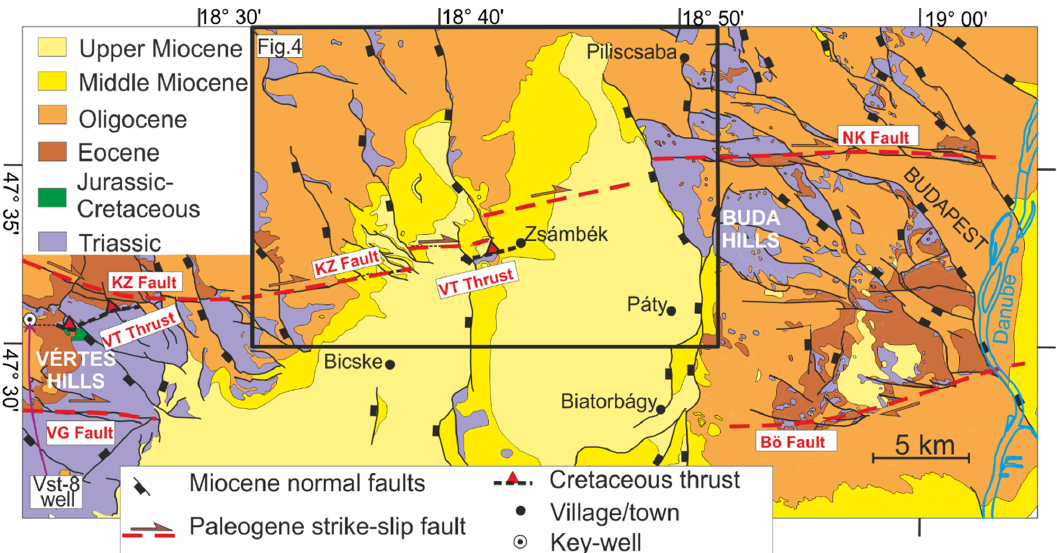
Figure 2. Pre-Quaternary geological map of the northeasternpart of the Transdanubian Range based on the maps of [24–28]. KZ = Környe-Zsámbék Fault, VT = Vértessomló Thrust, Nk = Nagykovácsi Fault, Vg = Várgesztes Fault, Bö = Budaörs Fault. For the position of the map within the Pannonian Basin, see Figure 1. The abbreviations “Fig.” refer to figures of this work.